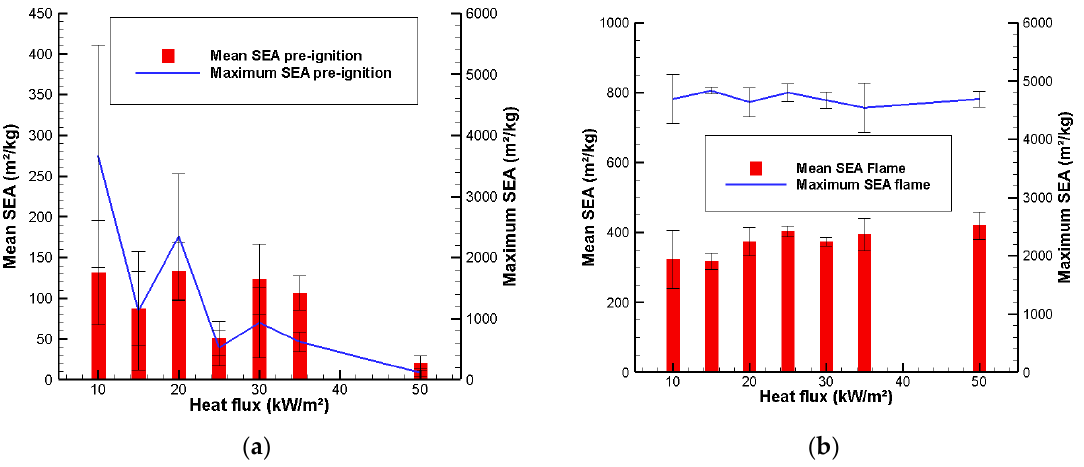
Figure 9. Smoke Extinction Area for an imposed heat flux of 10–50 kW/m 2 for thermoplastic samples during ( a ) pre-ignition phase and ( b ) flame phase.